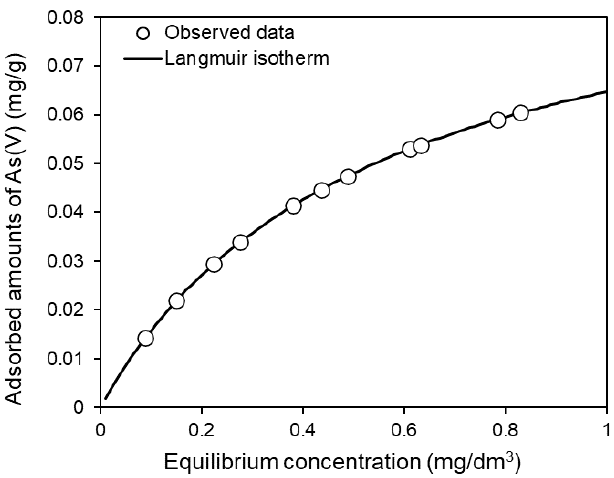
Figure 2. Adsorption characteristic of As onto RS fitted with Langmuir isotherm of As(V) for RS.